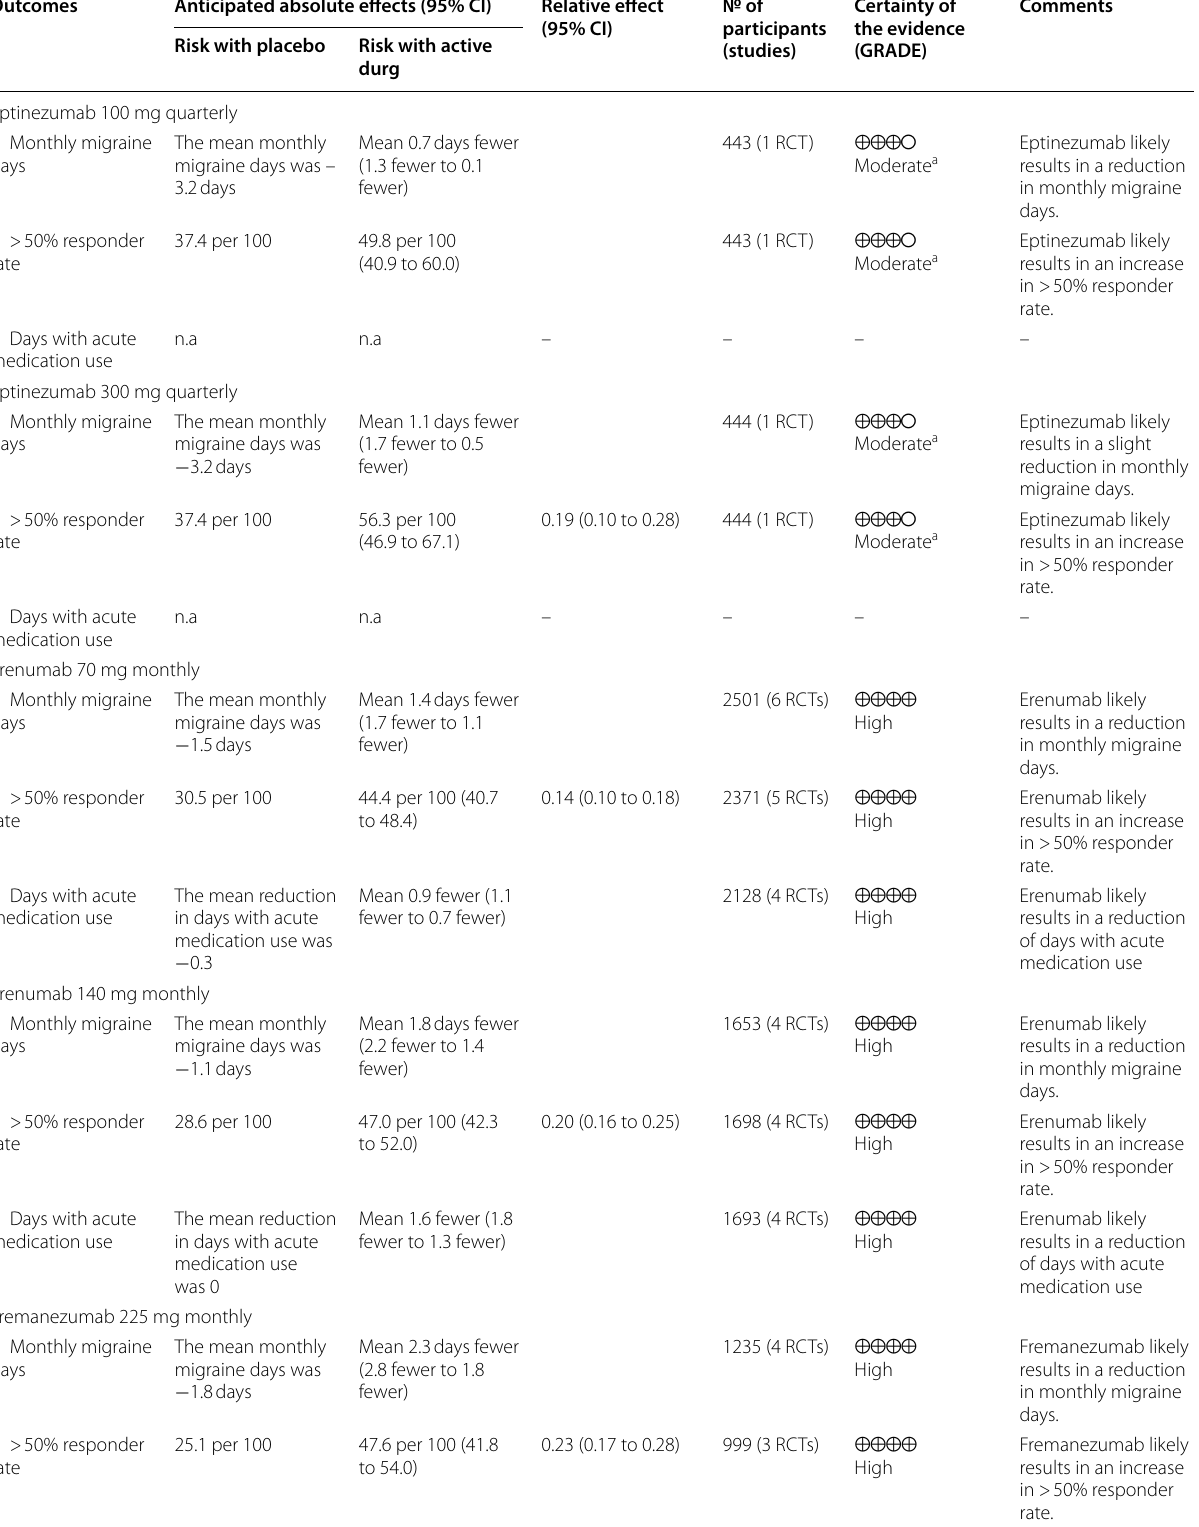
Table 4 Summary of findings for monoclonal antibodies targeting the CGRP pathway for the prevention of episodic